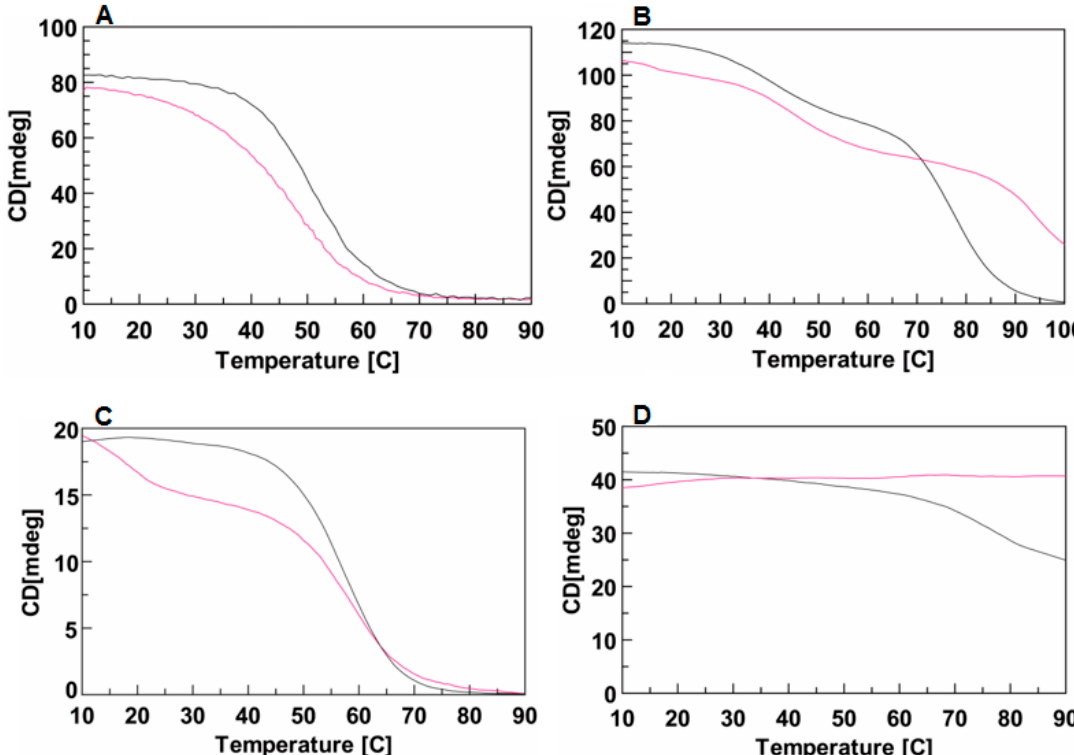
Figure 4. CD melting profiles of TBA or T30695 and of the corresponding conjugated sequences in di ff erent solvent conditions. ( A ) TBA (black line) and 5 (cid:48) -DMAzo-TBA (fuchsia line) in 100 K bu ff er (pH = 7.4). ( B ) T30695 (black line) and 5 (cid:48) -DMAzo-T30695 (fuchsia line), in 10 K bu ff er (pH = 7.4). ( C ) TBA (black line) and 5 (cid:48) -DMAzo-TBA (fuchsia line) in 5KEW blend. ( D ) T30695 (black line) and 5 (cid:48) -DMAzo-T30695 (fuchsia line) in 5KEW blend. [ON] = 2.0 µ